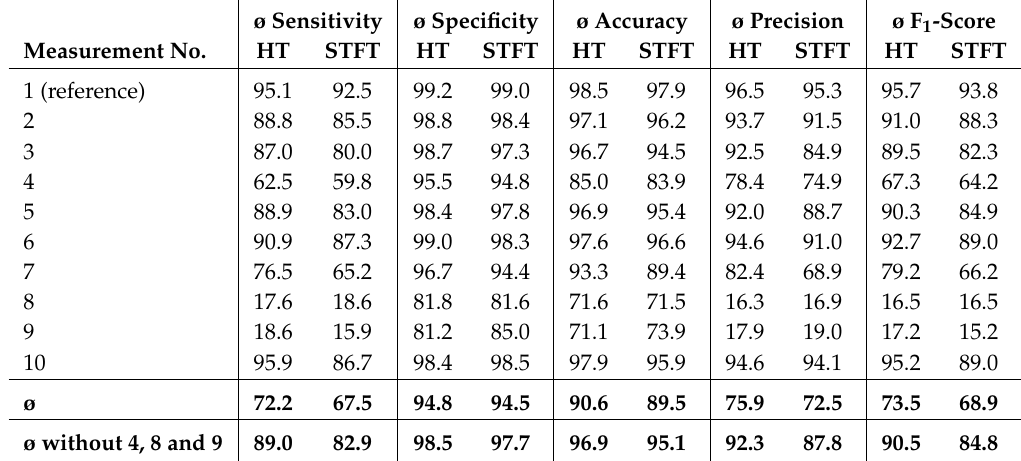
Table 4. Average values of the evaluation parameters (in %) for the single measurements. ø Sensitivity ø Specificity ø Accuracy ø Precision ø F 1 -Score Measurement No.